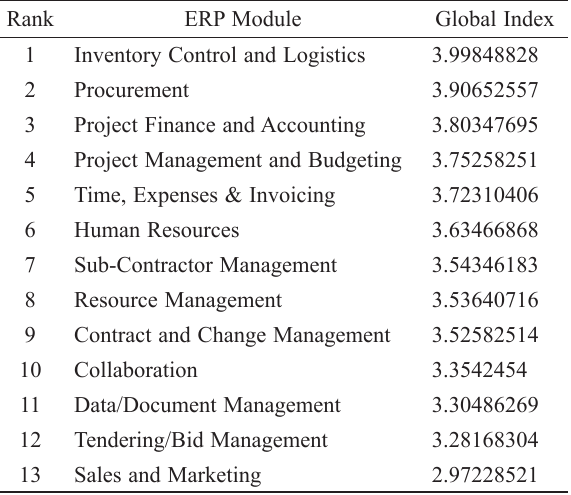
Table 5. Modules’ global